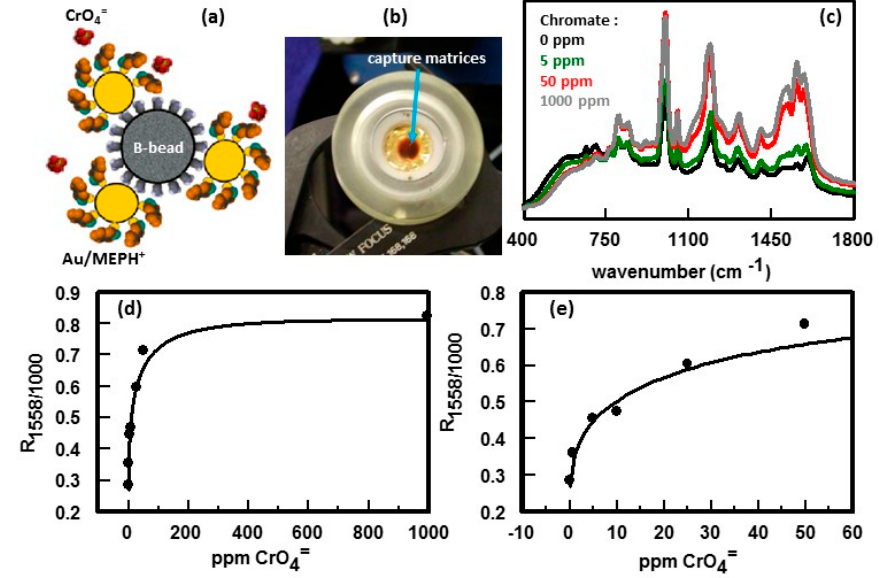
Figure 16. ( a ) Schematic of chromate interacting with a Au/MEPH + capture matrice. Capture matrices are comprised of functionalized Ag or Au NPs immobilized on magnetic beads (B-beads); ( b ) Use of a magnet to concentrate SERS-active capture matrices on an optical surface prior to detection; ( c ) SERS spectra of Au/MEPH + capture matrices immersed in chromate solutions. Chromate concentrations are indicated; ( d , e ) Plots of MEPH + peak intensity at 1558 cm − 1 ratioed to the 1000 cm − 1 peak as a function of chromate concentration. Reproduced with permission from Elsevier, 2013 [23].